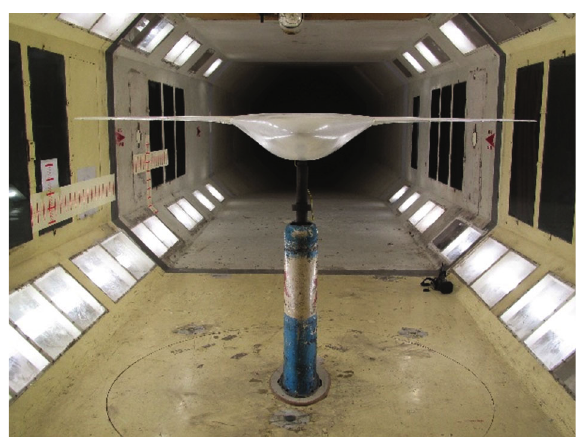
Figure 5: The grid of SWB.